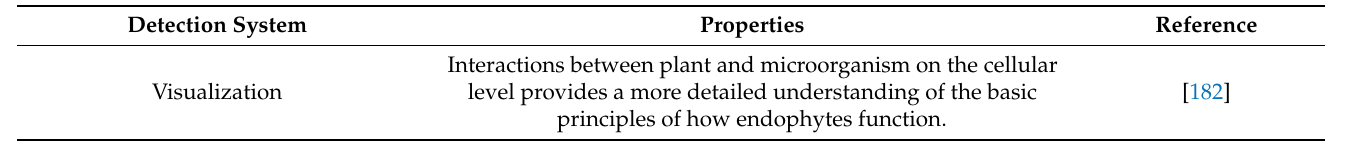
Table 2. Properties of the various microscopic techniques for the detection of microbial interaction (endophytic and pathogenic fungal